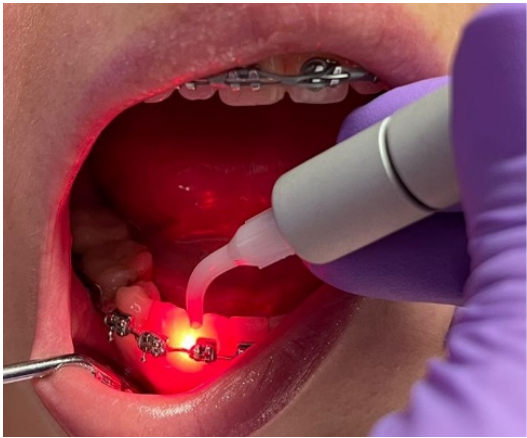
Figure 1. Laser therapy applied to a patient with a fixed orthodontic